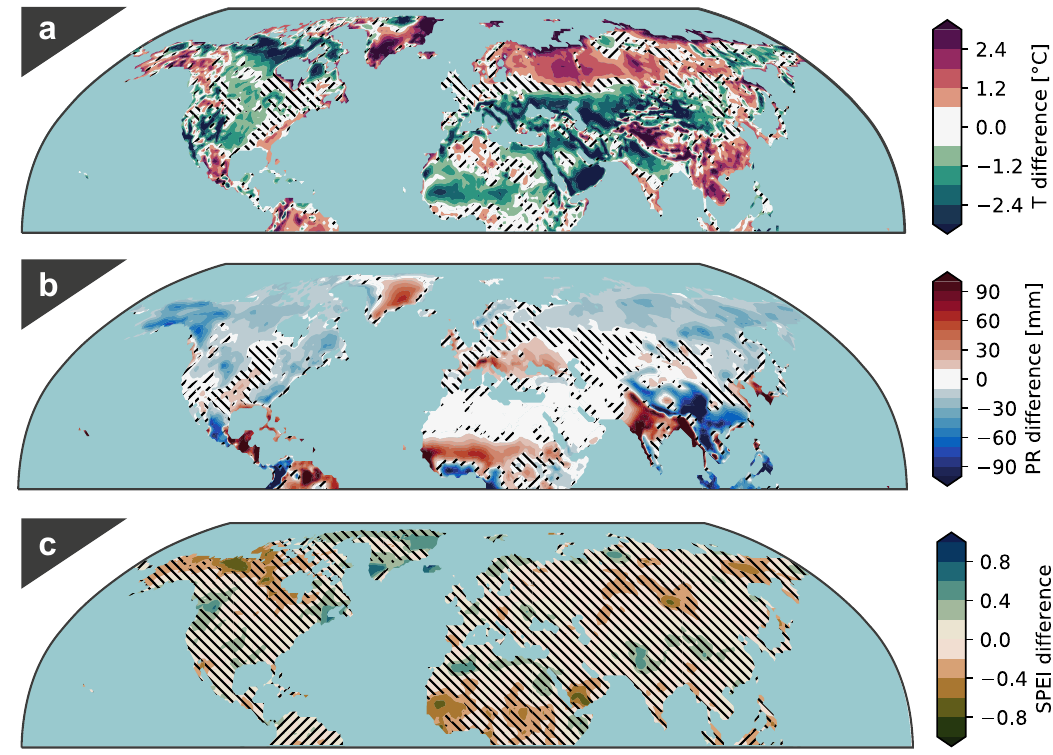
Fig. 1 Comparison of the modeled and observed climate for the period 1971 – 2000 (JJA only). a – c The climate simulations are averaged over the entire period and then subtracted from observations. a surface air temperature, b precipitation and c SPEI. The hatched areas indicate areas with insigni fi cant changes according to the two-sided Student ’ s t test ( p <